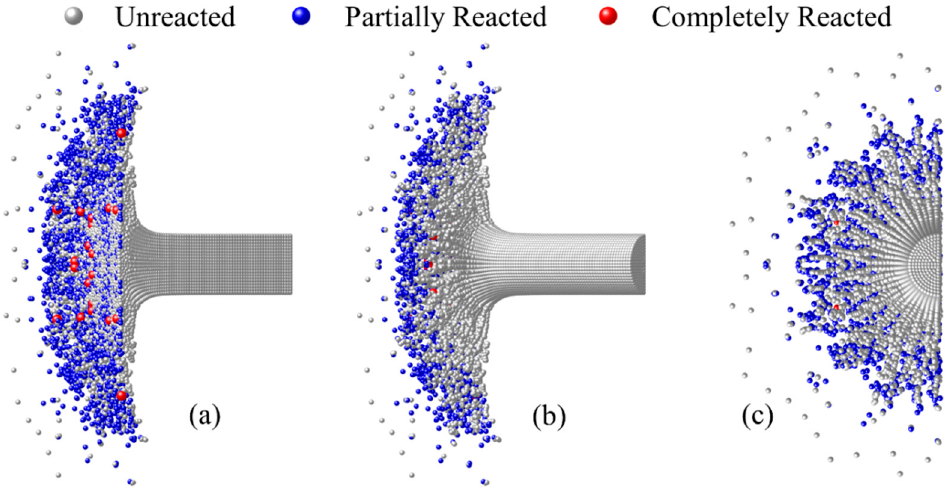
Figure 8. Images of RM rod from different perspectives at 775 m/s impact velocity and 30 μ s: ( a ) cross-section view with a rotation angle of 30°; ( b ) surface view with a rotation angle of − 30° and ( c ) top view.